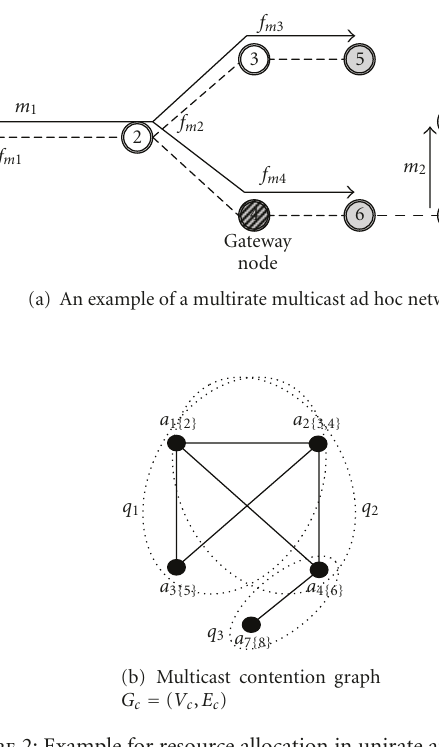
Figure 2: Example for resource allocation in unirate and multirate